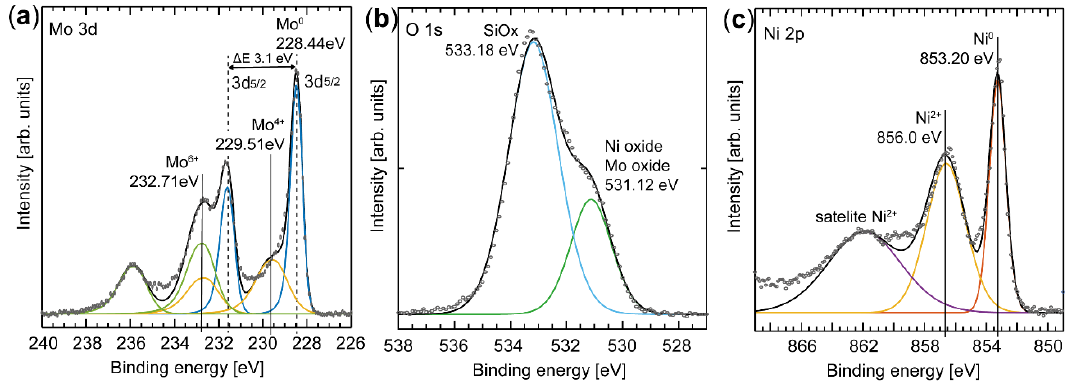
Figure 3. XPS spectra of Ni 2p 3 / 2 , O1s, and Mo 3d. The fits indicate that Ni and Mo are mixed, forming an alloy. ( a ) The Mo 3d spectrum is complex and the fitted components are color-coded to account for the spin-orbit splitting, and only the binding energy of the 3d 5 / 2 component is indicated. The peaks at 228.44 eV and 231.57 eV (blue) originate from metallic Mo. The peaks at 229.51 eV and 232.62 eV (yellow) are interpreted as originating from Mo 4 + . The most shifted component in binding energy at 232.71 eV and 235.81 eV (green) is assigned to Mo 6 + . ( b ) The O1s spectrum has two clear components assigned to the SiOx in the substrate and the oxide in the particles. ( c ) The Ni 2p 3 / 2 spectrum is fitted with three components, where the peak at 853.2 eV originates from metallic Ni, while the component at 856 eV is assigned to the oxide in the NiMoO 4 alloy.